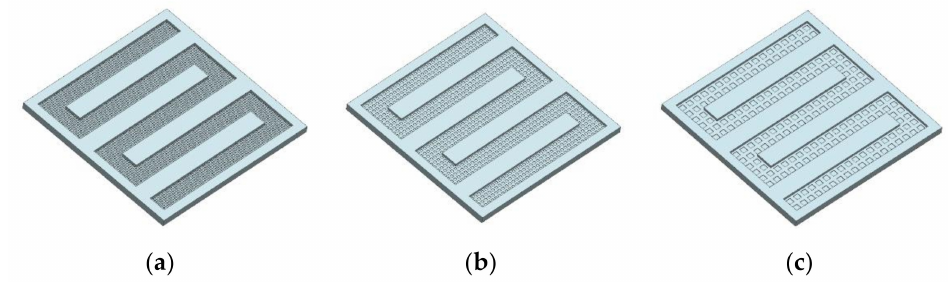
Figure 20. The three-dimensional structure of the half of fuel cell (( a ) pore size = 0.3 mm, ( b ) pore size = 0.6 mm, ( c ) pore size = 1.2